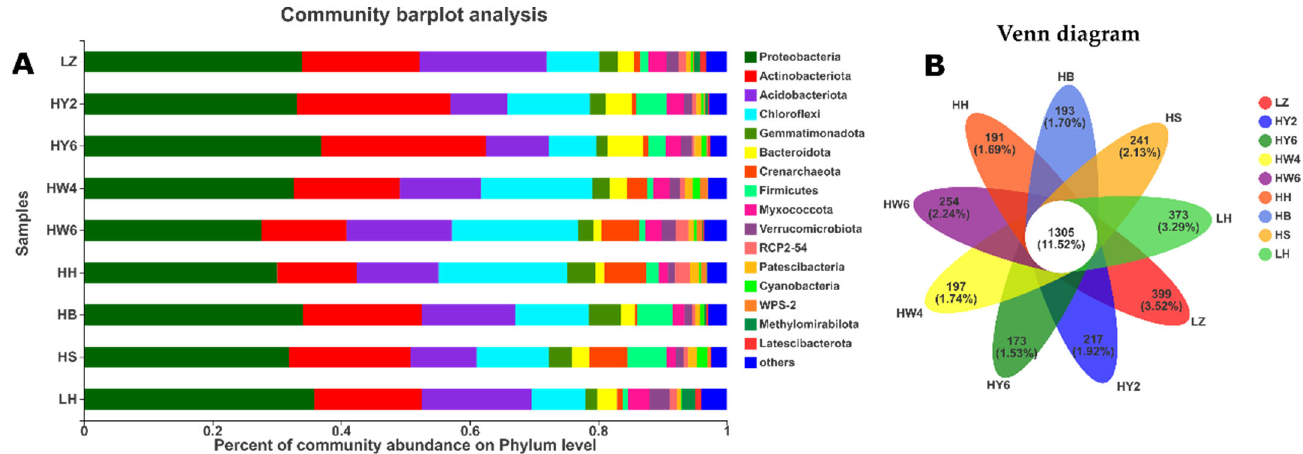
Figure 3. Bacterial composition and structure under different rotational cropping patterns. ( A ) Bacterial community barplot at the phylum level. ( B ) Venn diagram of unique and shared bacterial species among the fields. LZ, HY2, HY6, HW2, HW6, HH, HB, HS, and LH; continuous cropping of C. chinensis for 5 years, maize continuous cropping for 2 years, maize continuous cropping for 6 years, P. multiflorum continuous cropping for 2 years, P. multiflorum continuous cropping for 6 years, sweet potato continuous cropping for 2 years, F. thunbergia continuous cropping for 2 years, cabbage continuous cropping for 2 years, and fallow field, respectively.